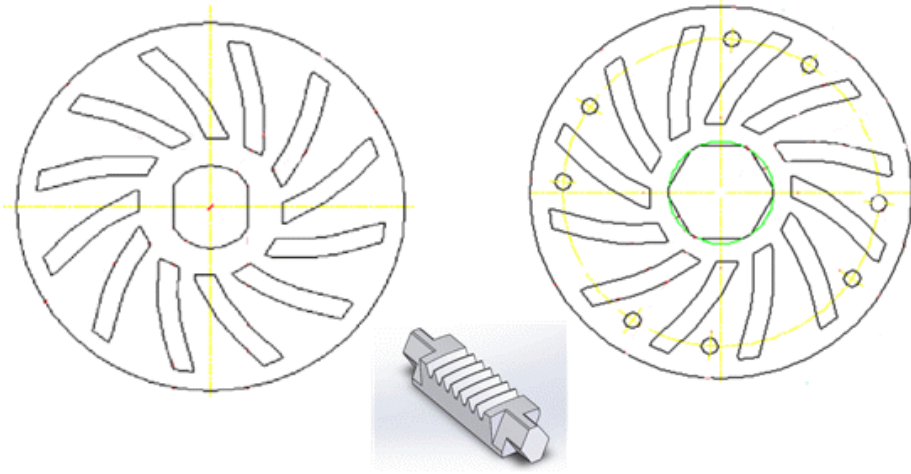
Figure 5. Slide plate and guide plate design with a spline curve.